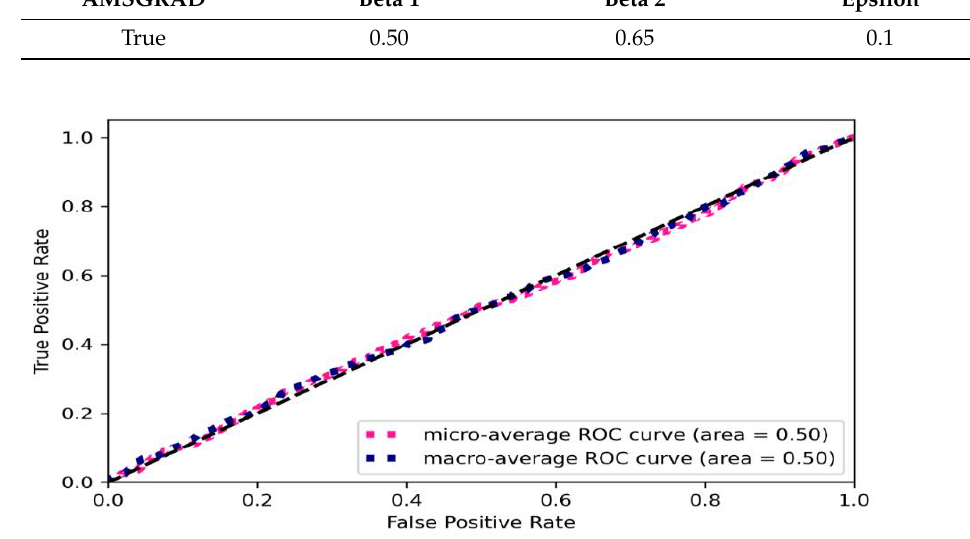
Figure 6. The area under the receiver-operating characteristic curve (ROC AUC) for the test set.